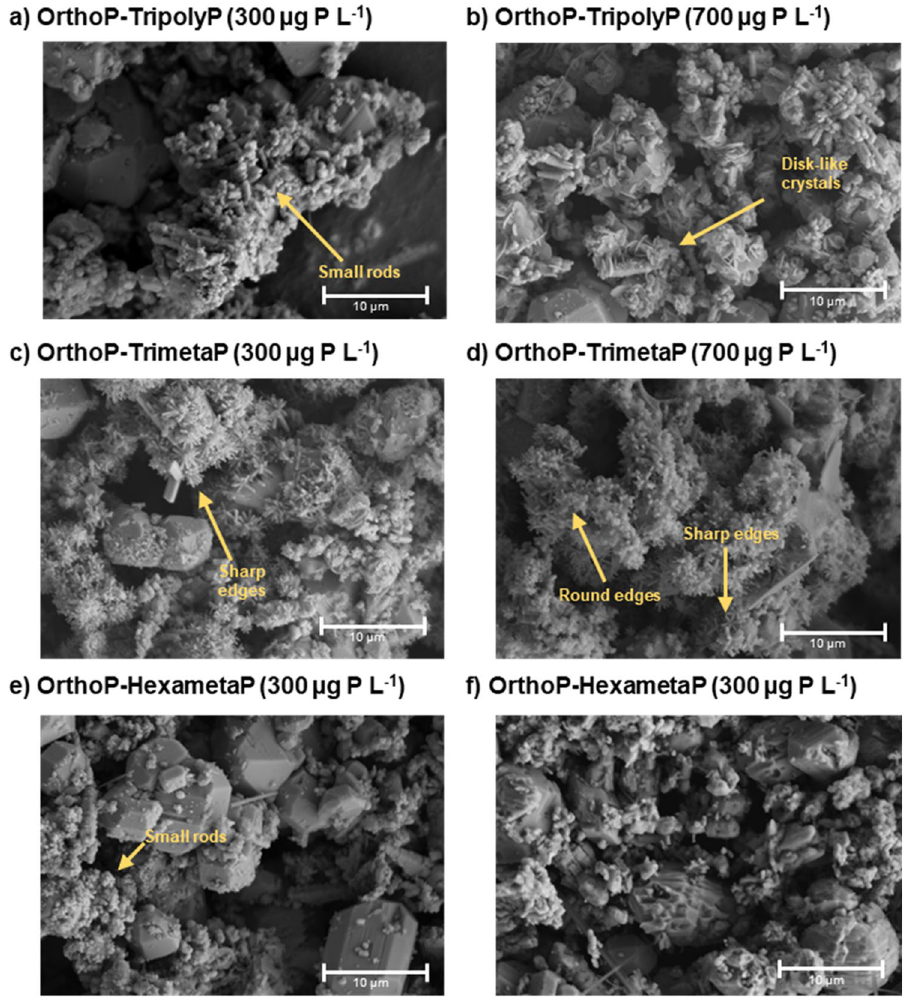
Figure 4. SEM images of lead particles from CSTR experiments after reactions with ( a , b ) orthophosphate- tripolyphosphate, ( c , d ) orthophosphate-trimetaphosphate, and ( e , f ) orthophosphate-hexametaphosphate at pH 7.5 and DIC 5 mg C L −1